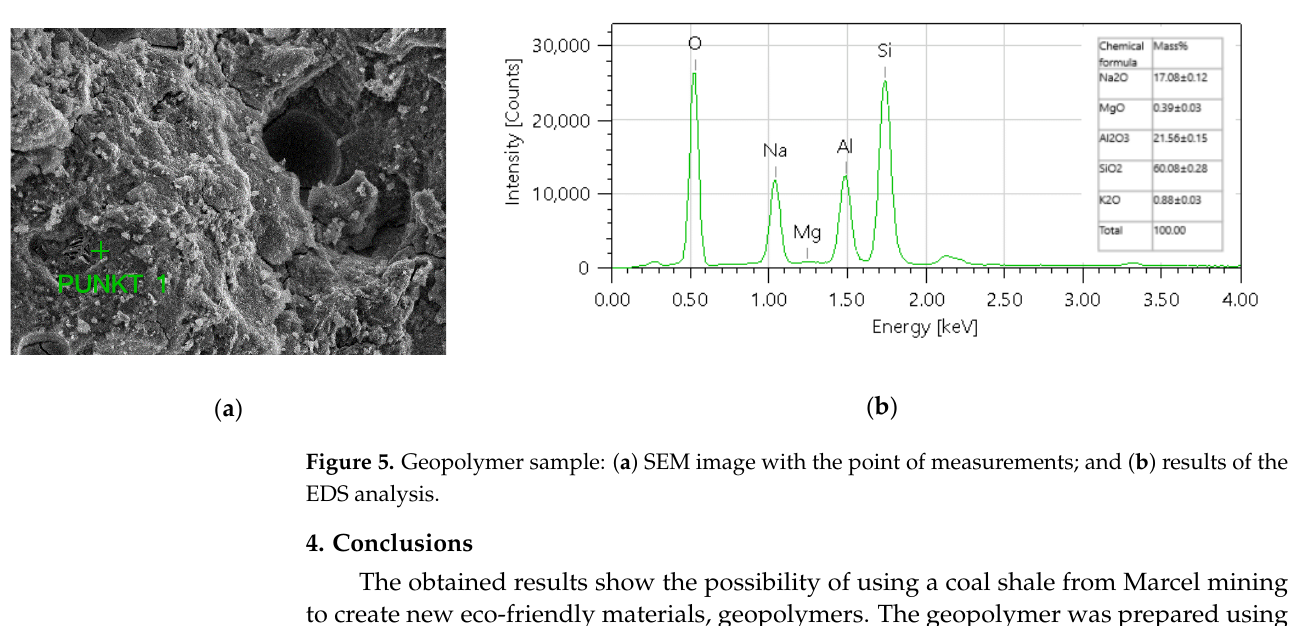
Figure 4. SEM images of geopolymer: ( a ) at 100× magnification; ( b ) at 200× magnification; ( c ) at 1000× magnification; and ( d ) at 2000× magnification.